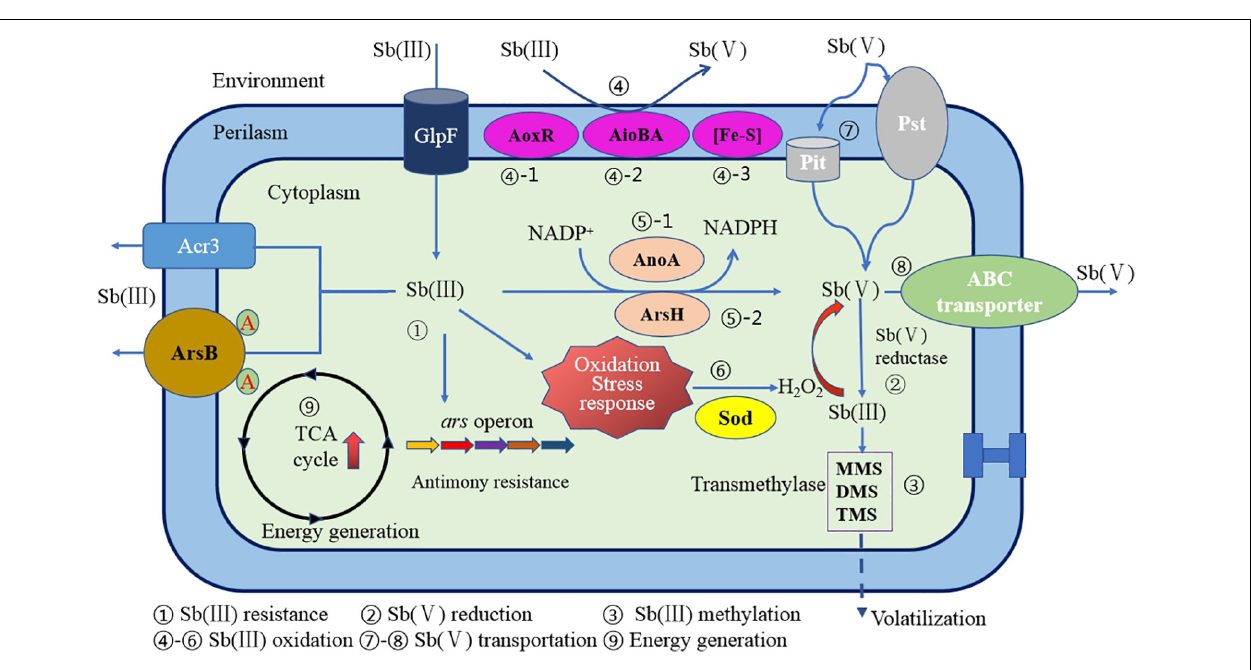
FIGURE 7 | A schematic diagram of Sb resistance of Sb-oxidizing bacteria and Sb(III) oxidation mechanism (Li,